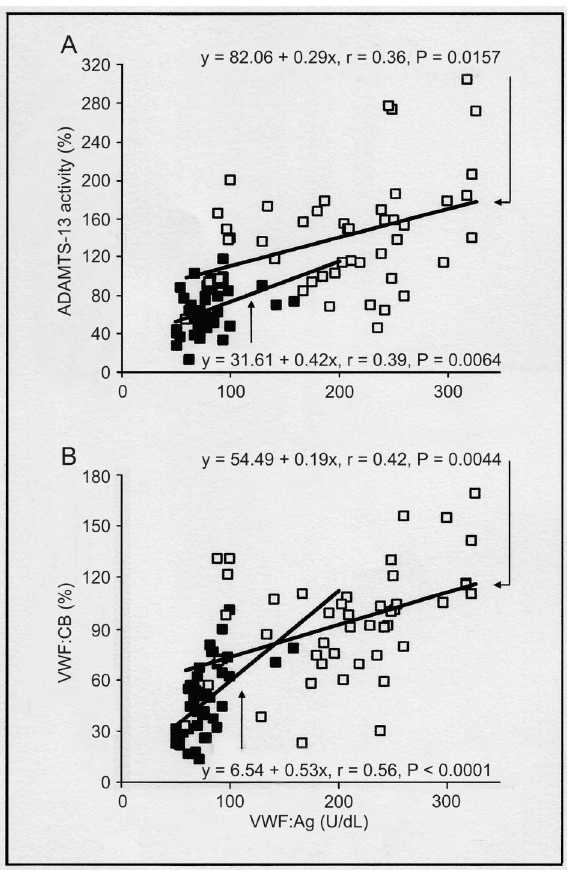
Figure 2. Preoperative (filled squares) and postoperative (open squares) correlations of plasma ADAMTS-13 activity ( A ) and